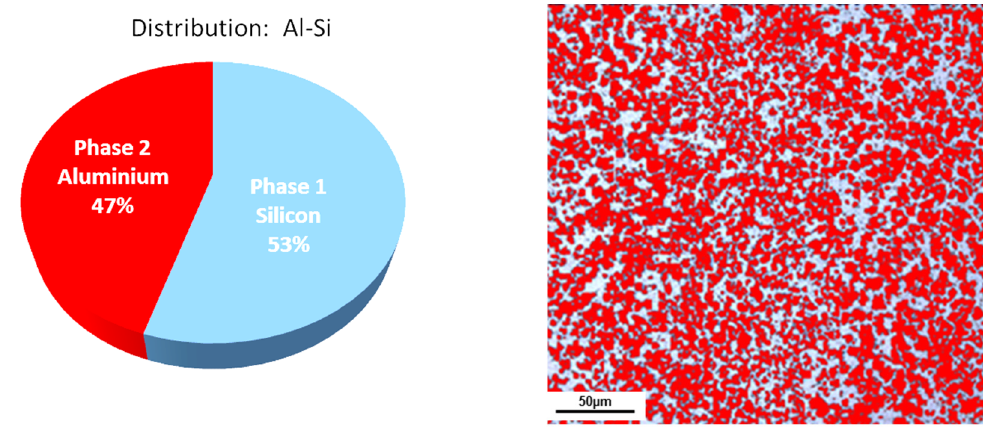
Figure 3. Volume fraction of elements in the hypereutectic rapidly solidified (RS) alloy.